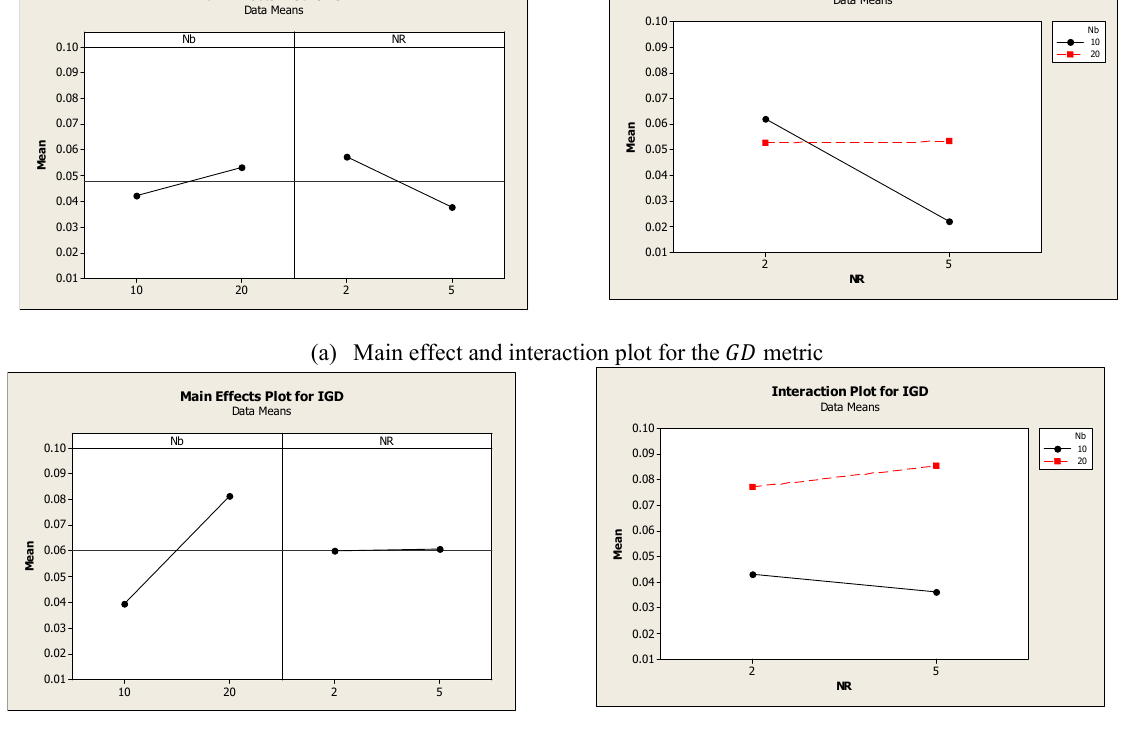
(b) Main effect and interaction plot for the 𝐼𝐺𝐷 metric Fig. 3 . 2 2 factorial design of experiments to determine the MOEA/D’s parameters